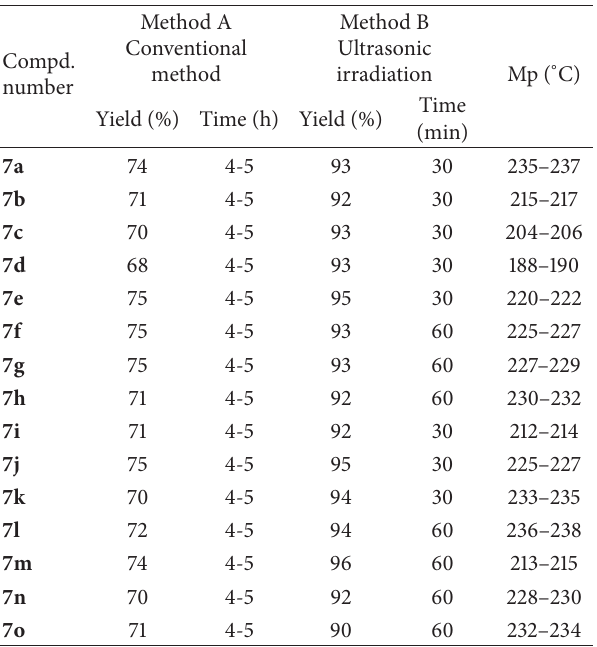
Table 1: Yield, reaction time, and melting point of 7a – o deriva- tivesusing conventional method and ultrasonic irradiation.